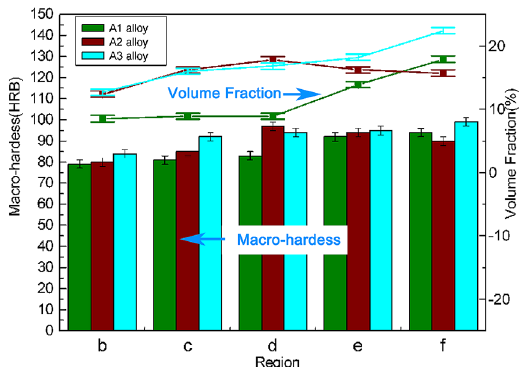
Figure 7. Relationships between the macro-hardness and the hard particles’ VFs of the pipes. Al (Fe, Mn) Si phase were analysed. Fig. 8 shows the TEM 15 3 2 bright-field images and selected area diffraction patterns of the Al FeSi phase and the laminar Al (Fe, Mn) Si phase 4 2 15 3 2 (sampled from the blocky phase by focused ion beam). The analysis showed that the Al FeSi phase was in the form of 4 2 a tetragonal structure with lattice constants a = 0.60641 nm Figure 8. TEM images of Fe-rich phases (a) bright-field and SAPD and c = 0.95258 nm, and the blocky Al (Fe, Mn) Si phase 15 3 2 of acicular Fe-rich phase; (b) bright-field and SAPD of blocky was a body centred cubic structure with lattice constants a = α-Al15(Fe, Mn)3Si2 phase sampled by 0.75198 nm and c = 0.77688 nm.